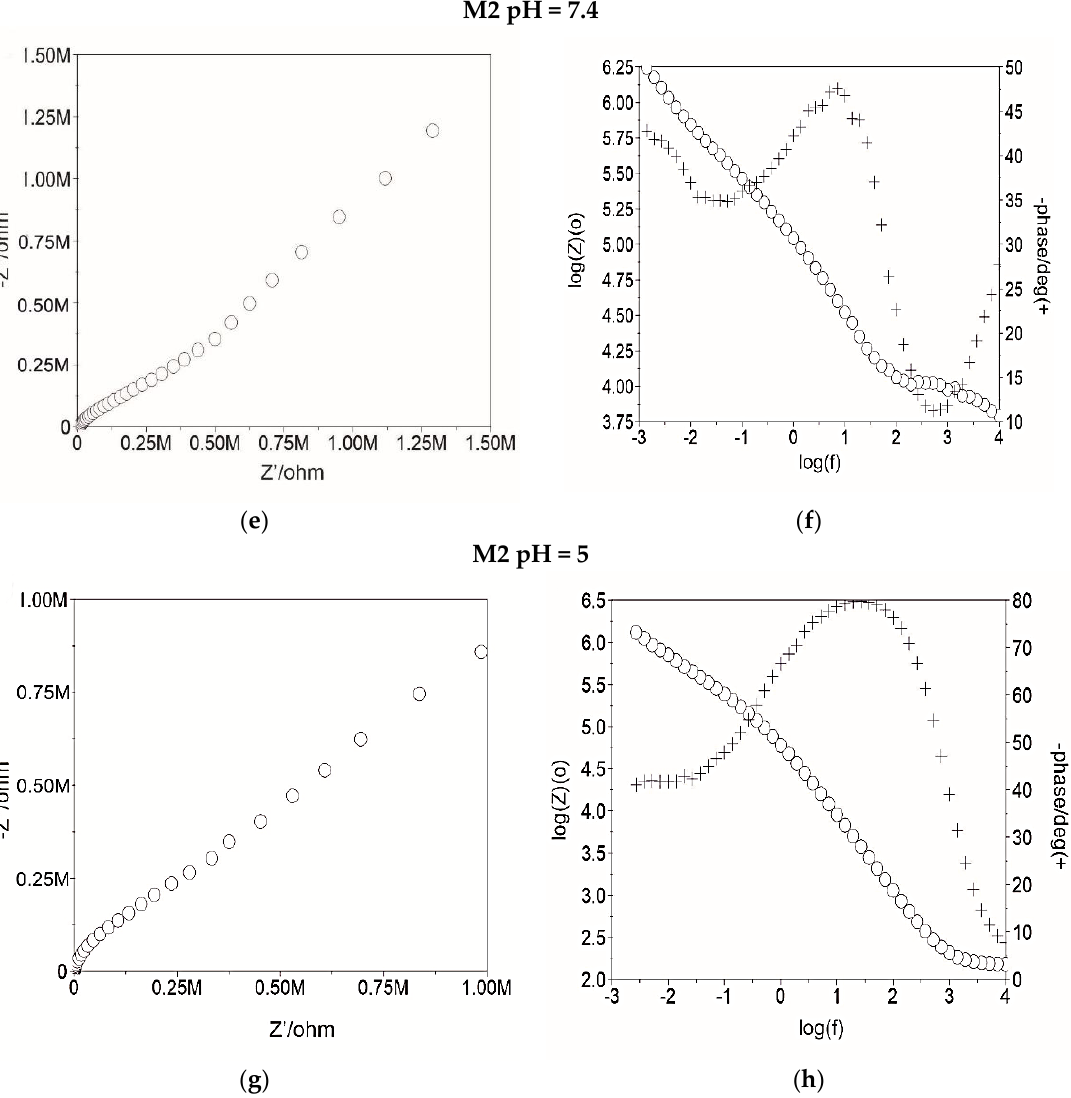
Figure 7. Examples of results of electrochemical impedance spectroscopy (EIS) test for M1 and M2 samples ( a , c , e , g ) Nyquist diagram; ( b , d , f , h ) Bode